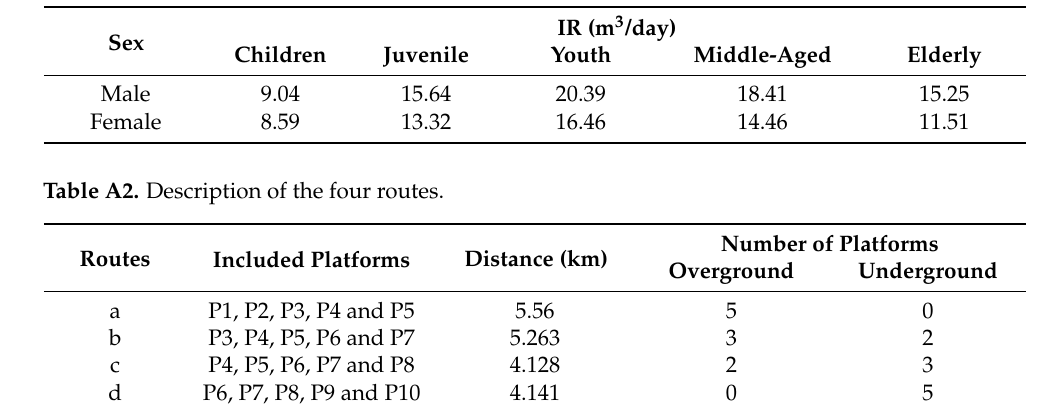
Table A1. Inhalation rates at different ages.